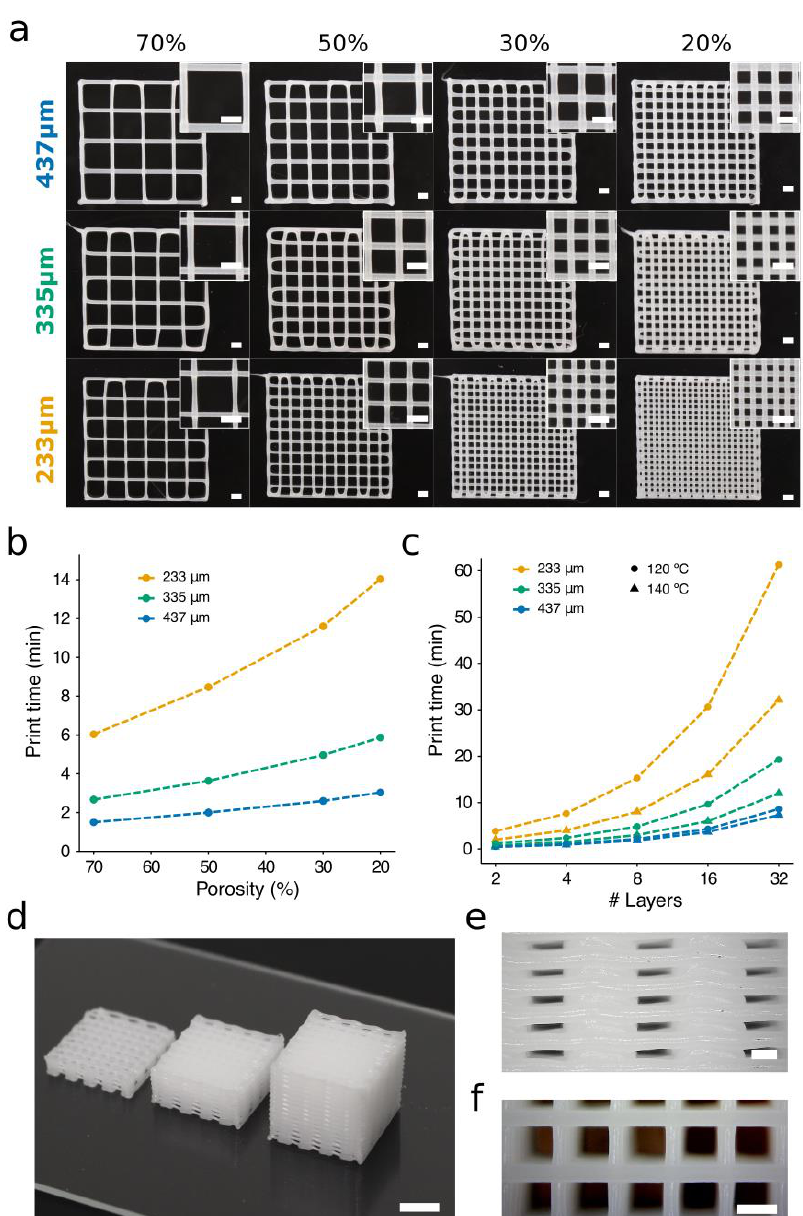
Figure 7. The influence of porosity percentage and layers stacked on the print time. ( a ) Two-layered PCL porous scaffolds of porosity ranging from 70 to 20% were printed using conical nozzles of three diameters at a target temperature of 120 °C and a pressure of 700 kPa. The travel speed of the printhead was adjusted to make the width of the strands match the nozzle ID (233 μm: 2 mm s − 1 ; 335 μm: 5 mm s − 1 ; 437 μm: 7 mm s − 1 ). Scale bars: 1 mm. ( b ) Print times to produce a 12 x 12 mm scaffold of eight layers and different degrees of porosity at 120 °C. The carriage speeds selected to produce strands of 335 μm diameter were 2, 5, and 11 mm s − 1 for 233-, 335-, and 437- μm nozzles, respectively. ( c ) Print times for a 12 mm square side scaffold, with 30% porosity and several layers stacked. Maximum print speeds were utilized for each nozzle – temperature configuration. ( d ) PCL porous structures created by stacking 8 (left), 16 (center), and 32 (right) layers. Scale bar: 5 mm. Side ( e ) and top ( f ) views of 3D scaffold of 32 layers printed with a 437- μm nozzle at 140 °C and a speed of 14 mm s − 1 . Scale bars: 500 μm.